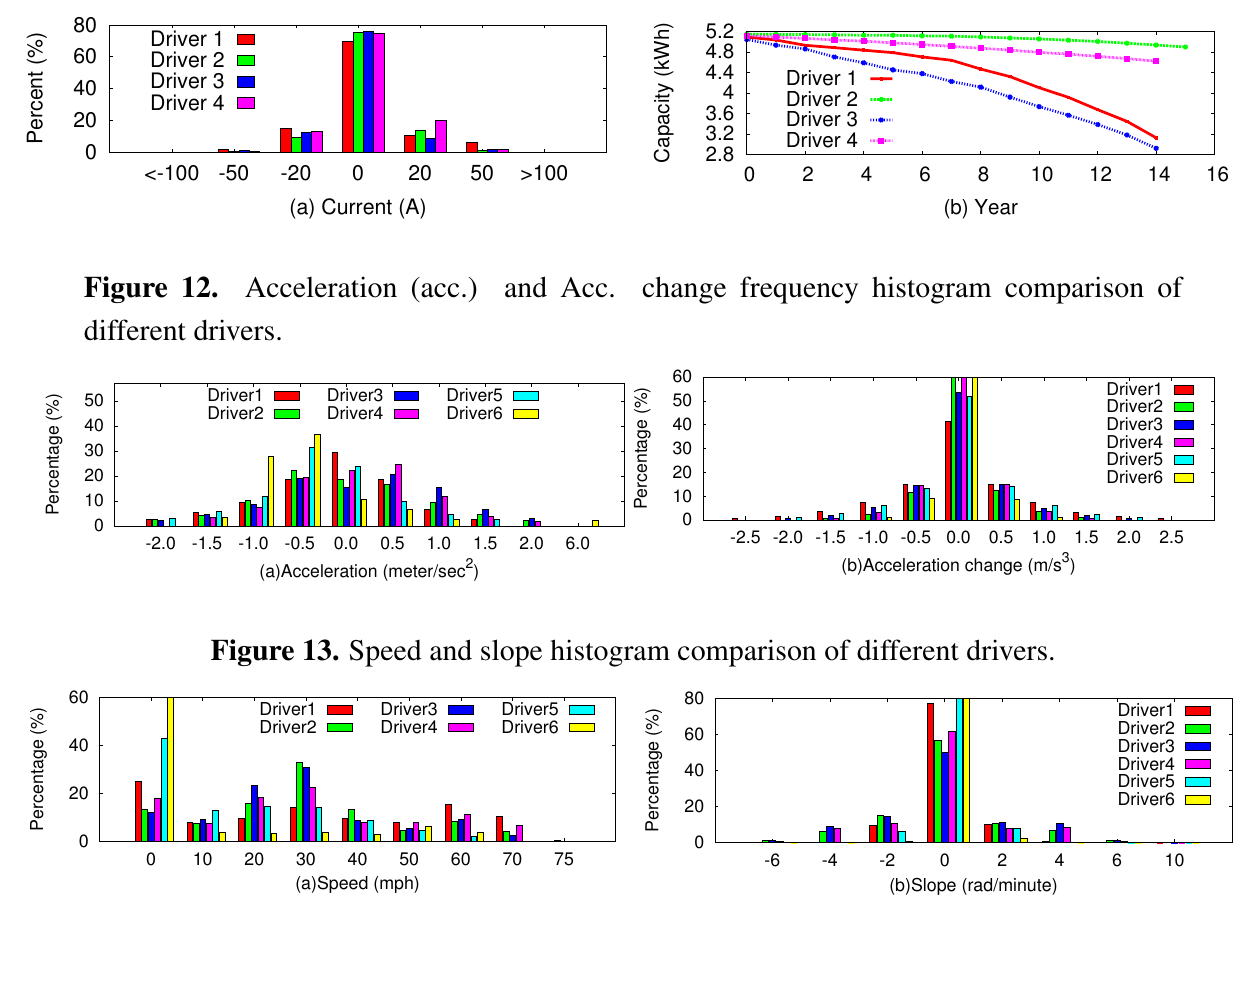
Figure 11. Battery use and capacity loss comparison of different drivers on the same route.